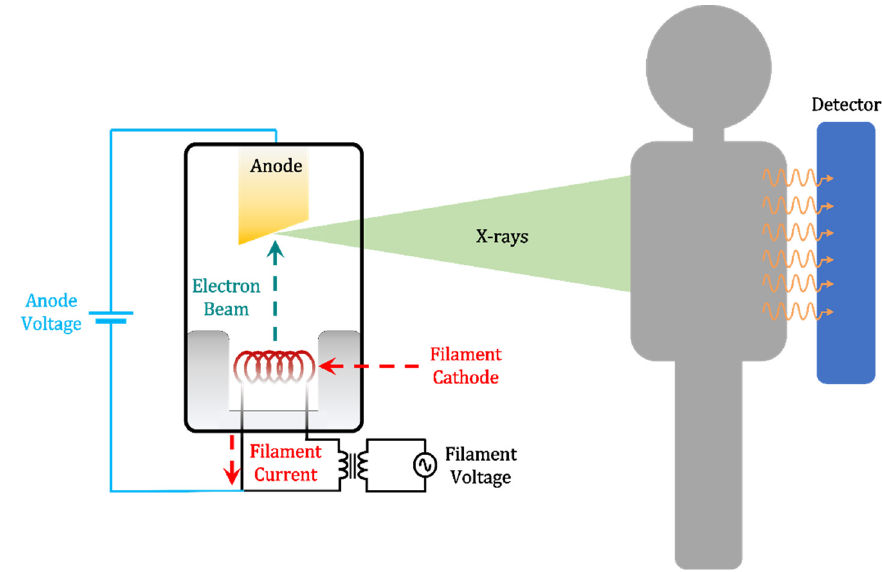
Figure 1. Schematic of the X-ray image acquisition.